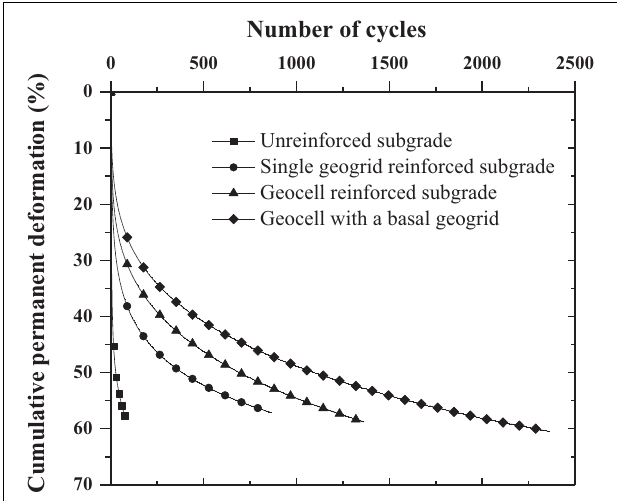
listed in Table 4 .